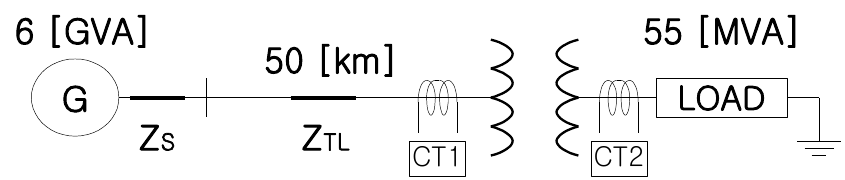
Figure 4. A single line diagram of the simulated